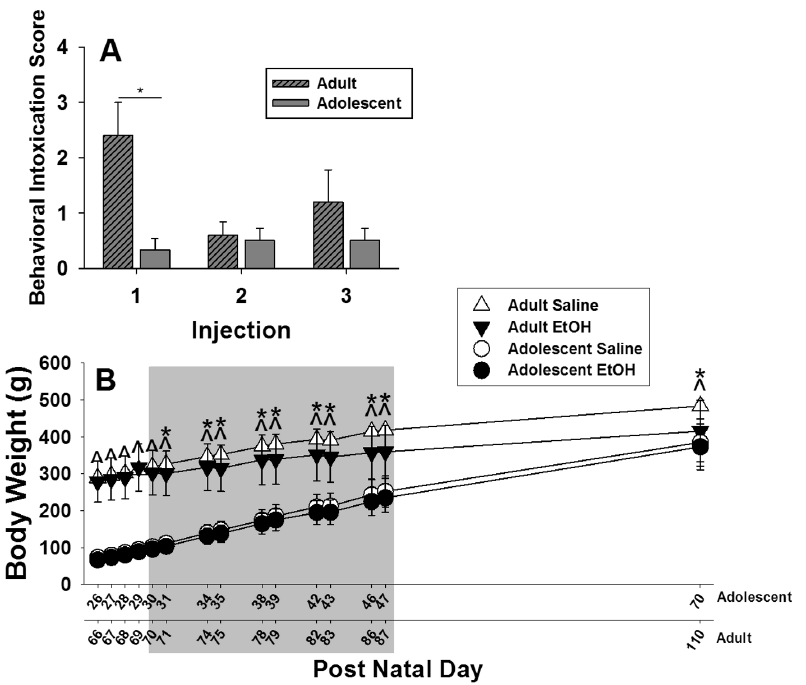
Figure 6. Behavioral intoxication scores after the first three CIE EtOH administrations (panel A) and body weights before, during and after CIE (panel B). Data are expressed as group mean 6 SEM. For the behavioral intoxication score, the asterisk denotes a significant effect of age (adolescent vs. adult independent of CIE exposure) on a specific day ( Post-hoc t -test with a Sˇida´k adjustment for multiple comparisons, p , 0.05). For the body weights, carats denote a significant effect of age at treatment (adult-treated vs. adolescent-treated independent of CIE exposure). Asterisks denote a significant effect of CIE exposure (ethanol vs. saline) in only adult CIE-exposed rats on a specific day ( Post-hoc t -test with a Sˇida´k adjustment for multiple comparisons, p , 0.05). There were no significant differences in body weights between CIE- and saline-exposed adolescent rats. doi:10.1371/journal.pone.0062940.g006 CIE-exposed age-matched counterparts throughout the CIE period. There were no differences between CIE-exposed and saline-exposed adolescent rats.